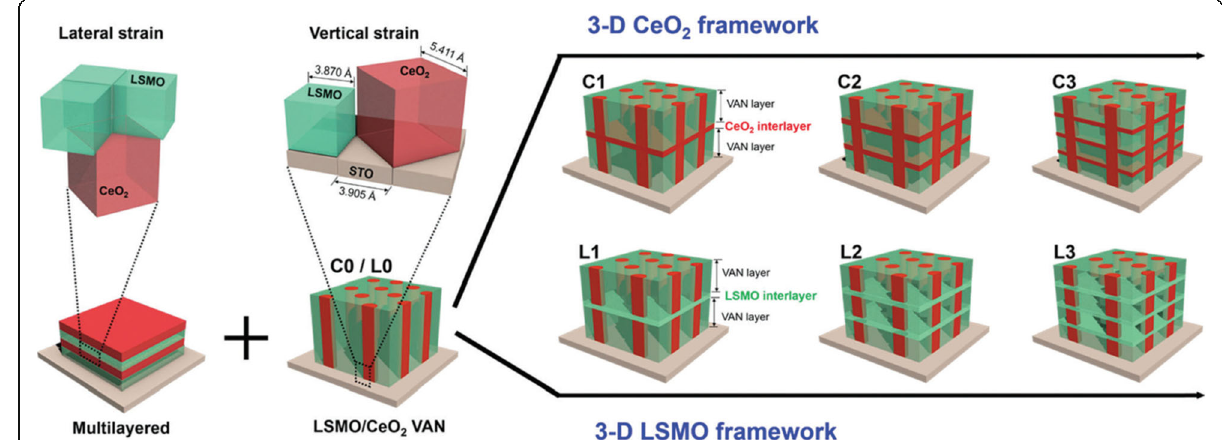
Fig. 17 Schematic illustration of 2-phase heterogeneous microstructure evolution of the thin films: from vertical aligned nanocomposite (VAN) C0/L0 to 3D CeO 2 framed thin films C1 – C3 and 3D La 0.7 Sr 0.3 MnO 3 (LSMO) framed thin films L1 – L3. The 3D framed microstructure is achieved by alternative growth of the single phase and the VANs in multilayered fashion. This design combines the lateral strain introduced from multilayered thin film and the vertical strain from interfacial coupling in VANs, creates 3D interconnected CeO 2 or LSMO framework microstructures within the thin films, and provides a versatile tool to achieve 3D strain tuning. The unit cells and phase of LSMO are in green, and the unit cells and phase of CeO 2 are in red. The single layer LSMO – CeO 2 VAN thin films are named as C0 or L0, without LSMO or CeO 2 as the interlayers. 3D CeO2 interlayered thin films with 1, 2, and 3 interlayers inserted in VAN structures are named as samples C1, C2, and C3, respectively. Similarly, 3D LSMO interlayered thin films with 1, 2, and 3 interlayers inserted in VAN are named as sample L1, L2, and L3, respectively. Reproduced with permission of